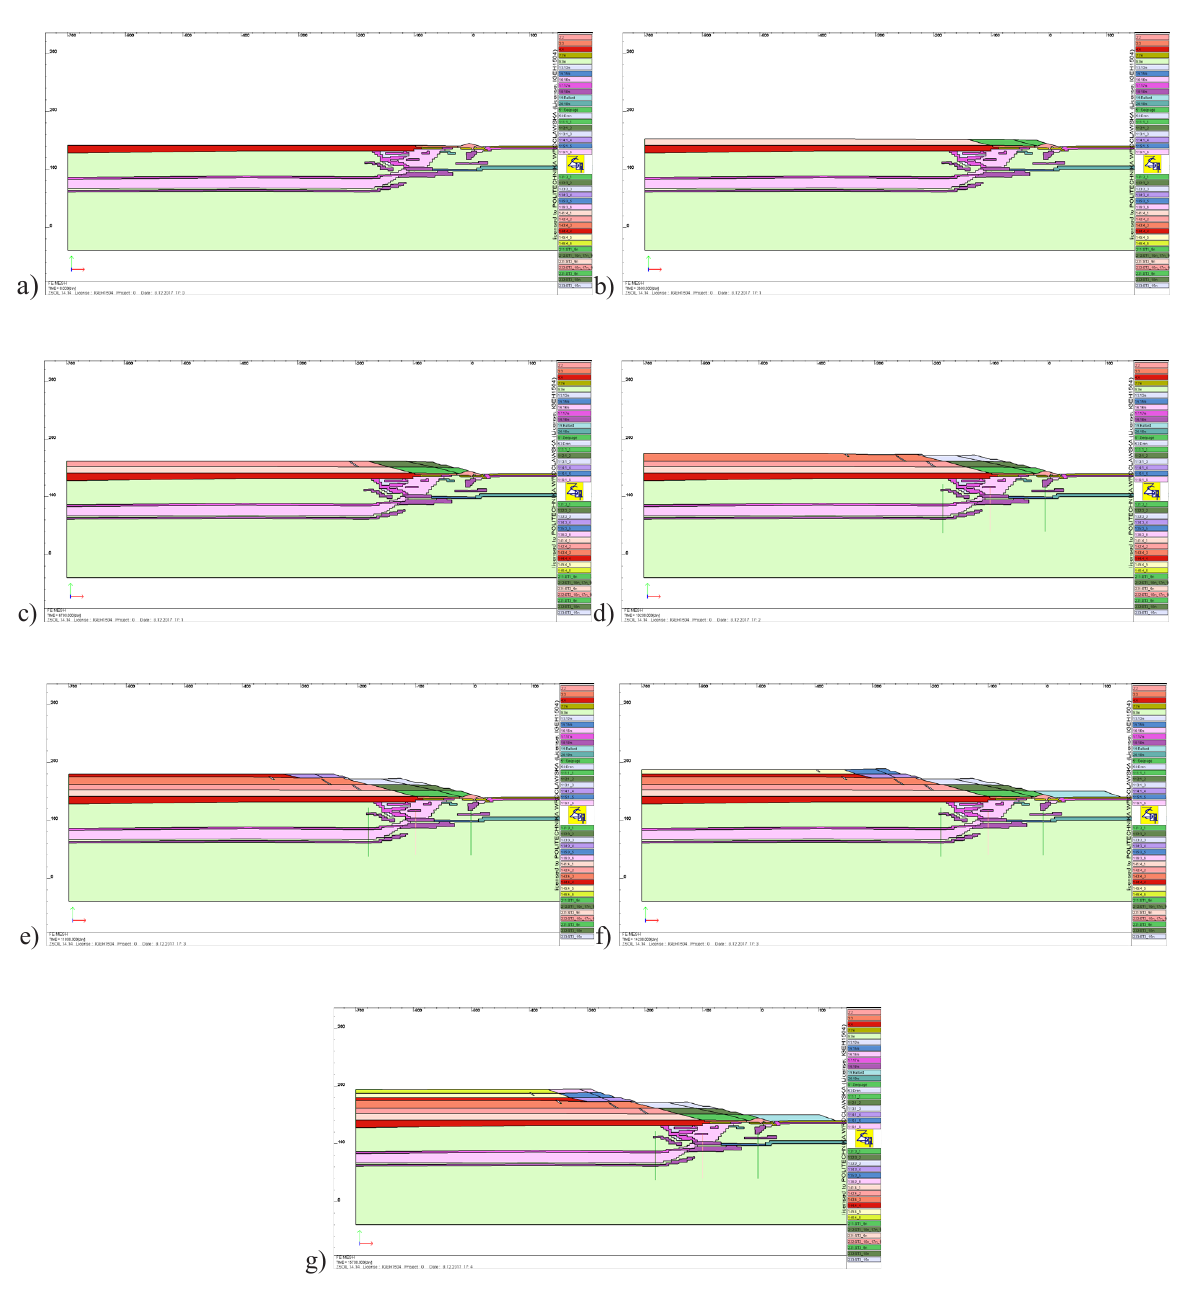
Figure 7: Geometry of the FE model in the VaN cross-section for individual stages of the dam raise, corresponding to the crest elevation [m a.s.l.]: a) 140.0, b) 150.0, c) 160.0, d) 173.5, e) 180.0, f) 189.0, g)